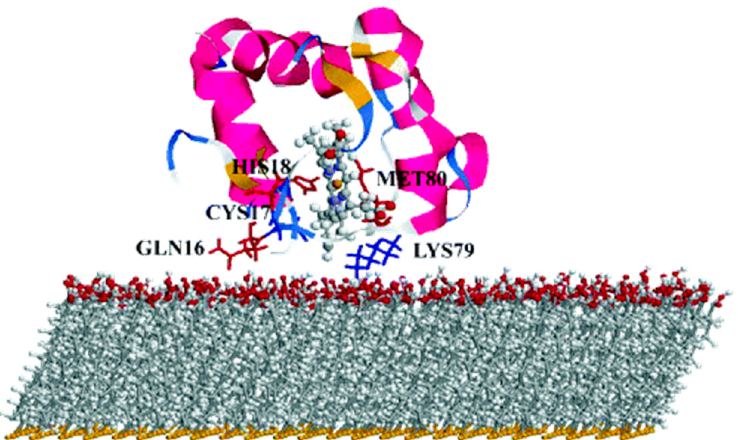
Figure 12. Simulation-predicted electron-transfer pathway of cyt on negatively charged surfaces. Reprinted with permission from [179]. Copyright (2004) American Chemical Society.